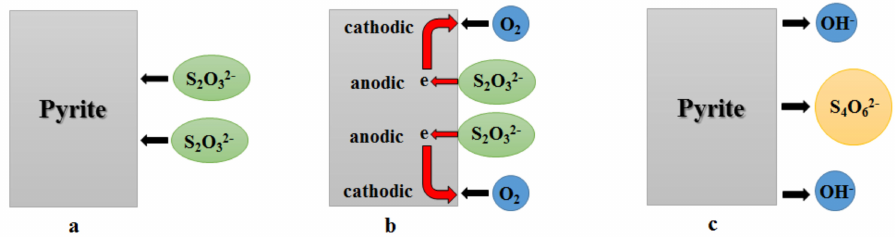
Figure 4. Step-oxidation of thiosulfate catalyzed by pyrite. ( a ) the adsorption of thiosulfate; ( b ) the transfer of electrons; ( c ) the formation of reaction